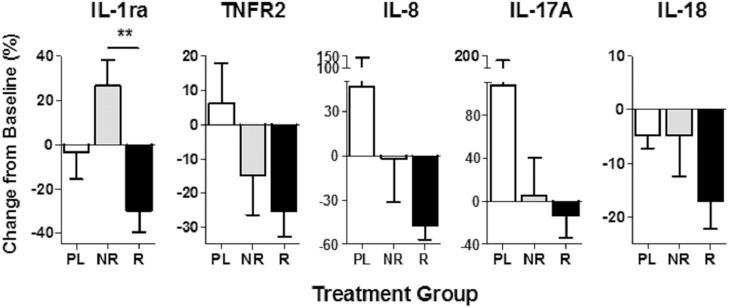
Dalazatide inhibits multiple soluble mediators of inflammation associated with psoriasis.PL = placebo group; R = improvement in target lesion, NR = no improvement in target lesion 60 mcg/dose dalazatide group. Data represent mean ± SEM of the % change from Day 32 relative to baseline (Day 1). **P < 0.01, two-tailed student’s t-test.